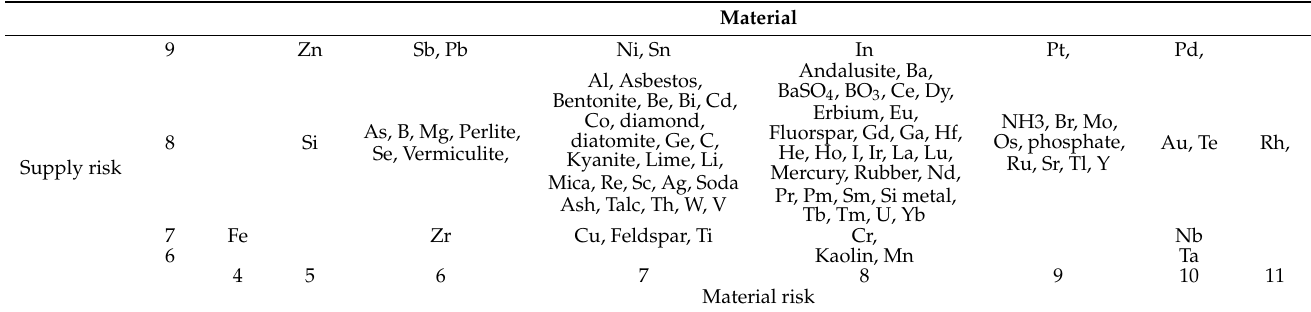
Table 6. Supply Risk and Material Risk of materials.